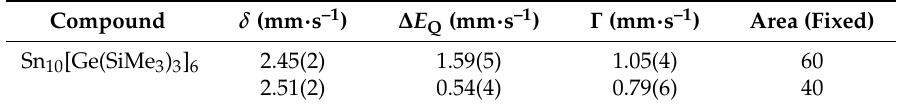
Figure 2. Experimental (data points) and simulated (continuous lines) 119m Sn Mössbauer spectrum of Sn 10 [Ge(SiMe 3 ) 3 ] 6 1 at 5 K. For the fitting parameters, see Table 2. Table 2. Fitting parameters of the 119m Sn Mössbauer spectroscopic measurement at 5 K. δ = isomer shift, ∆ E Γ = experimental line Q = electric quadrupole splitting,